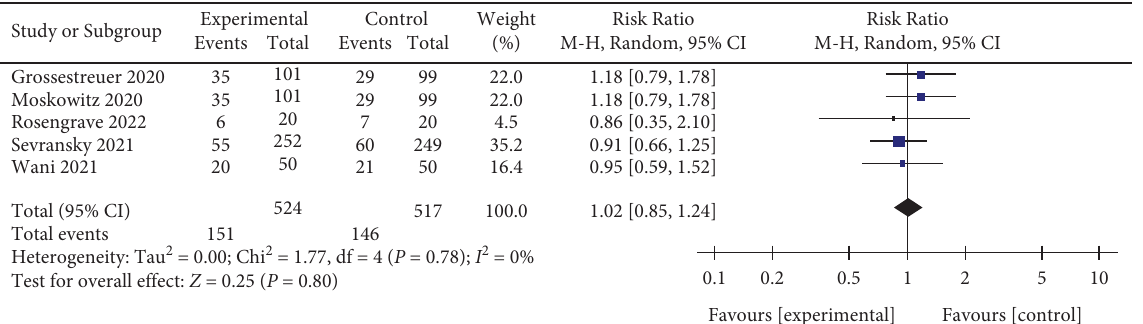
Figure 6: Forest plots for the efect of vitamin C on the 30-day